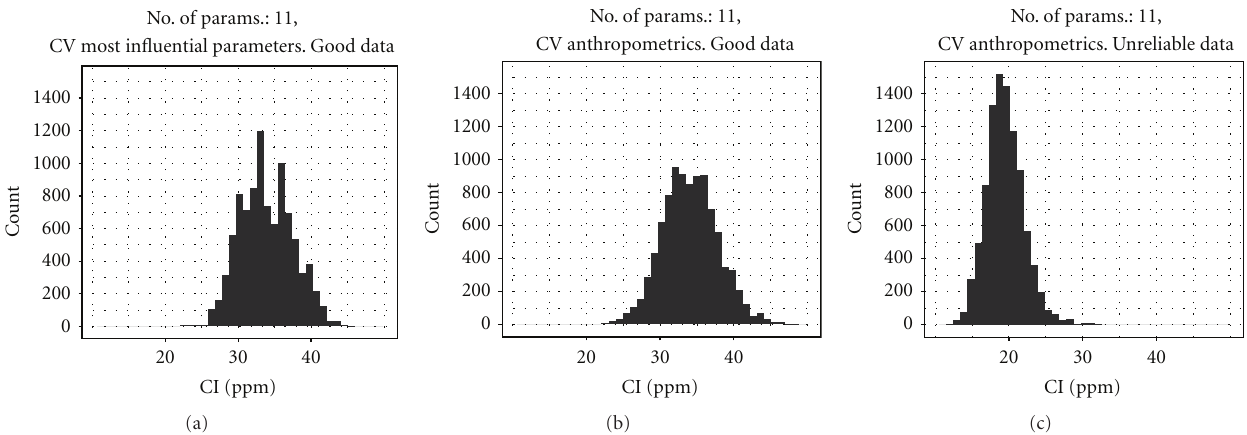
Figure 8: Comparison of estimated posterior distributions for 4-hour inhalation exposure to m -xylene. Posterior distributions were estimated by updating the most influential parameters or by fixing the measured parameters and updating the remaining most influential: (a) CV, most influential, (b) CV, fixed, measured, and remaining most influential, (c) CV, most influential, using unreliable